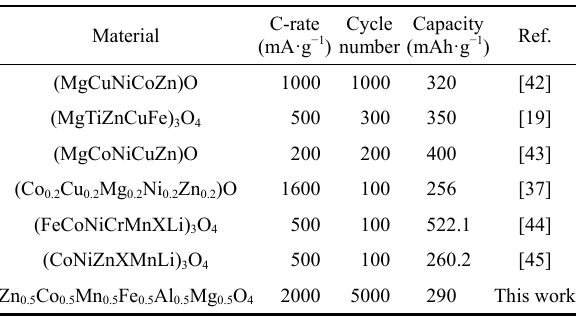
Fig. 7 Electrochemical performance of 6M-HEO-950 sample: (a) first three consecutive CV curves at a scan rate of 0.1 mV·s − 1 , (b) first three cycles of galvanostatic charge–discharge profiles at 1 A·g − 1 , (c) cycling performance at 2 A·g − 1 , (d) rate performance and galvanostatic charge–discharge profiles at different currents, (e) CV curves at different scan rates, and (f) corresponding b values, where b is the fitting parameter that can be evaluated from the slope of the log i vs. log v curve. Electrochemical performance of recently reported HEO